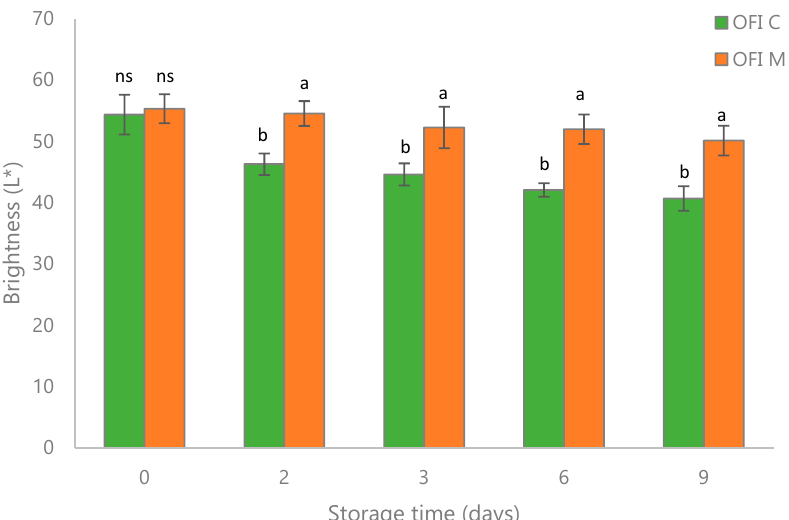
Figure 2. Changes in brightness (L*) in minimally processed O. ficus-indica fruits non-treated (OFI C) and treated with mucilage (OFI M) during cold storage (9 days at 5 °C). Different lowercase letters indicate significant differences at p ≤ 0.05 between the treatments in each sampling date. Data are the mean ± SE (Vertical bars represent standard error; n = 5).